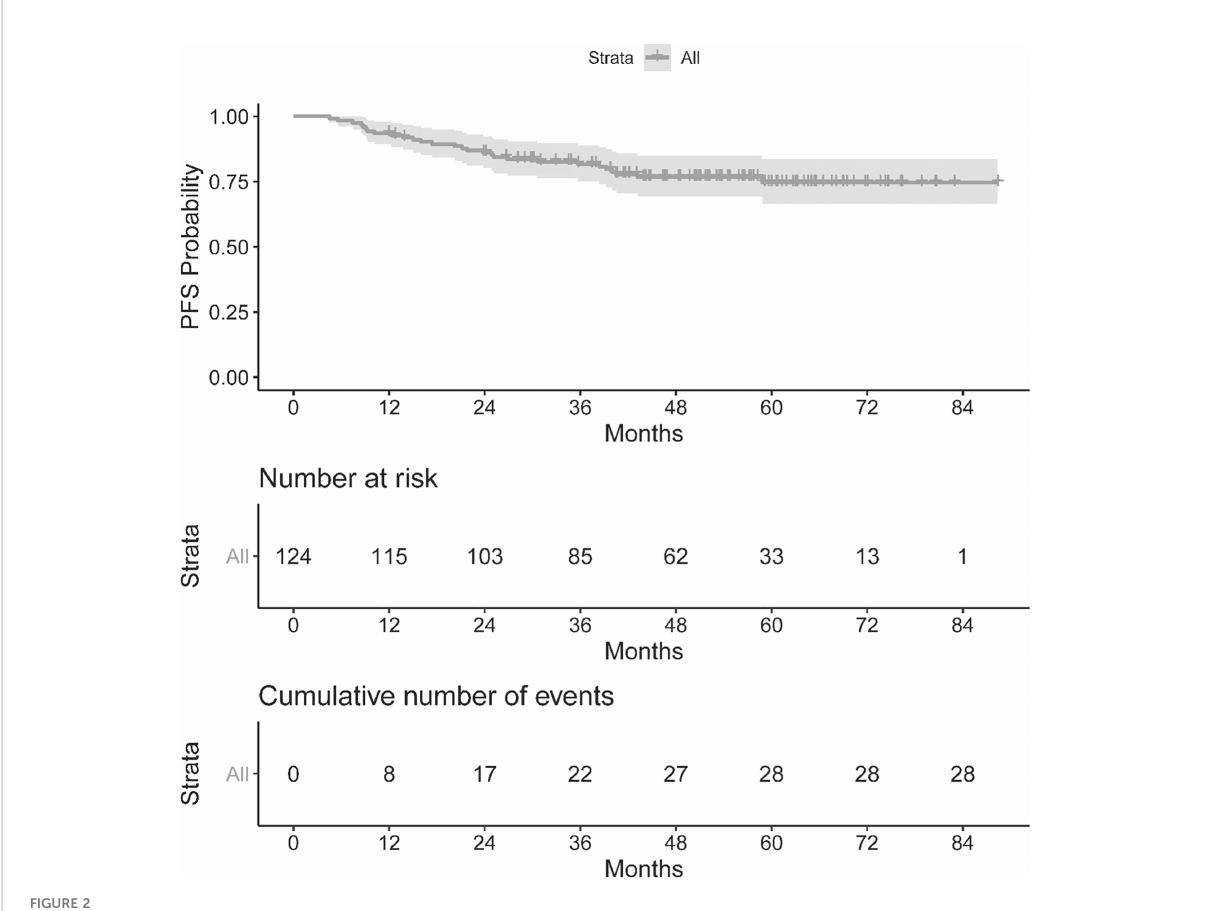
FIGURE 2 Kaplan Meier curve for Progression Free